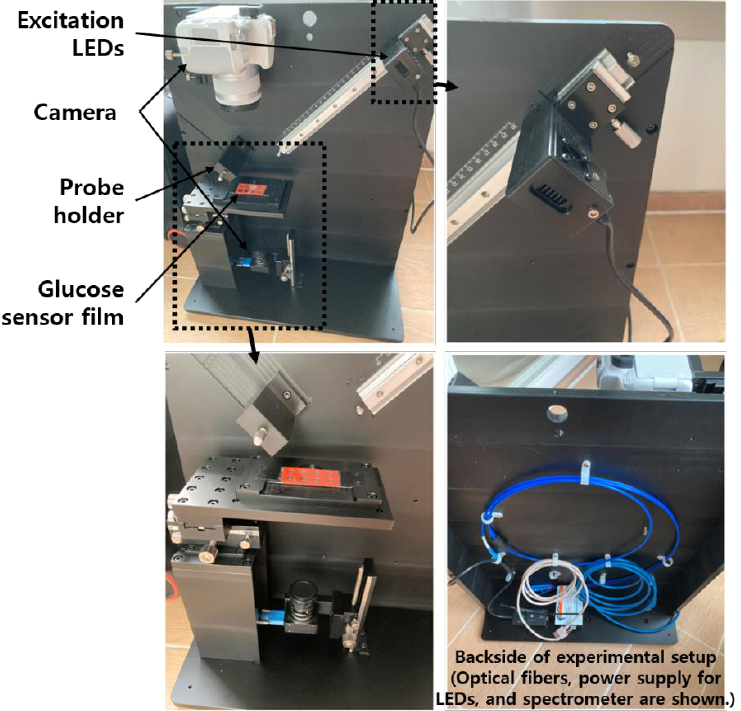
Figure 2. Photos of a test fixture for quantitative analysis of a prototype glucose sensor.